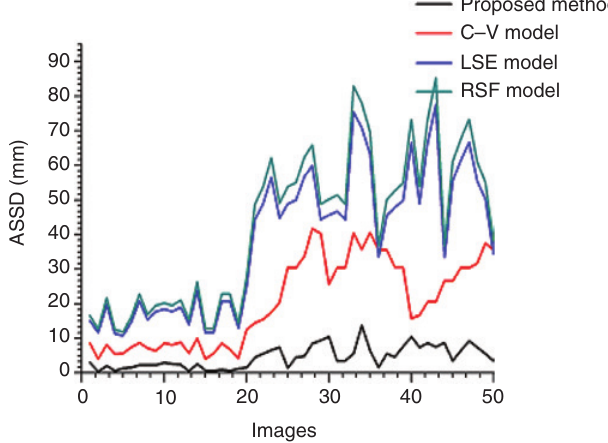
Figure 12: Comparison of Results Using ASSD for MRI Scan Images.